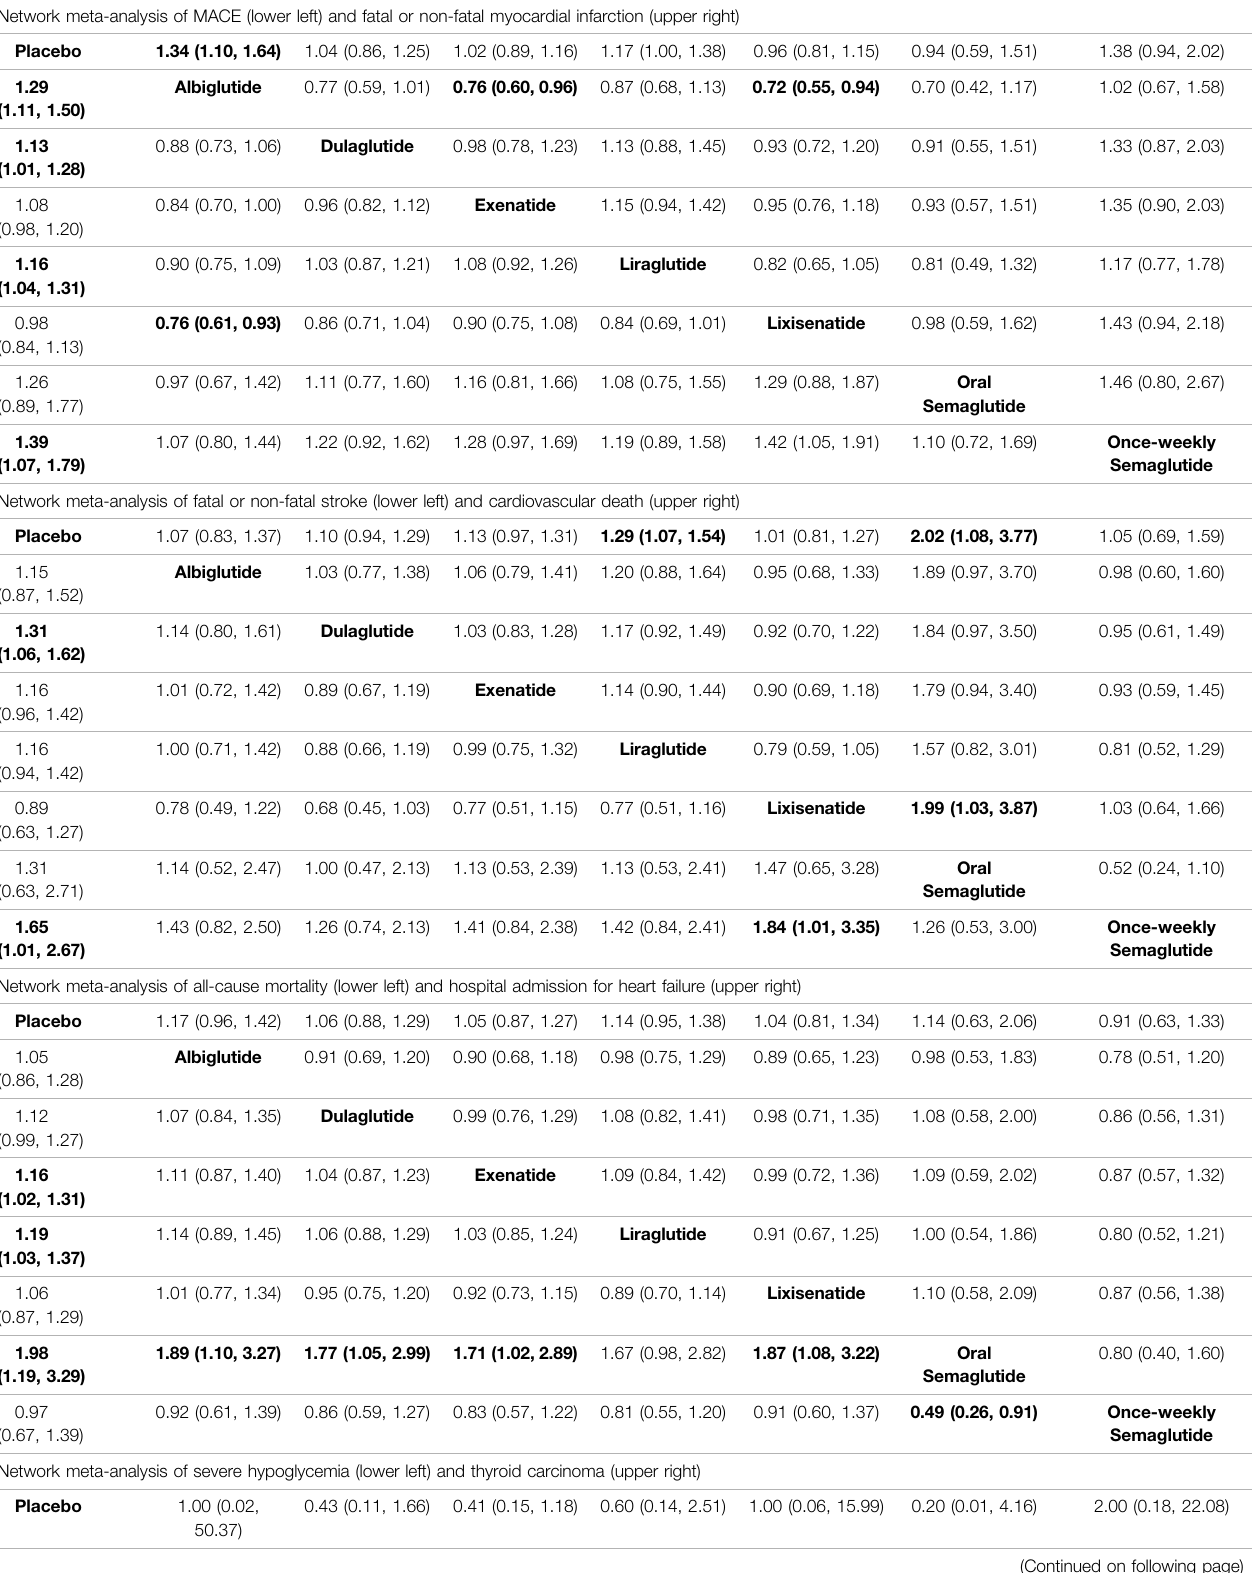
Network meta-analysis of severe hypoglycemia (lower left) and thyroid carcinoma (upper